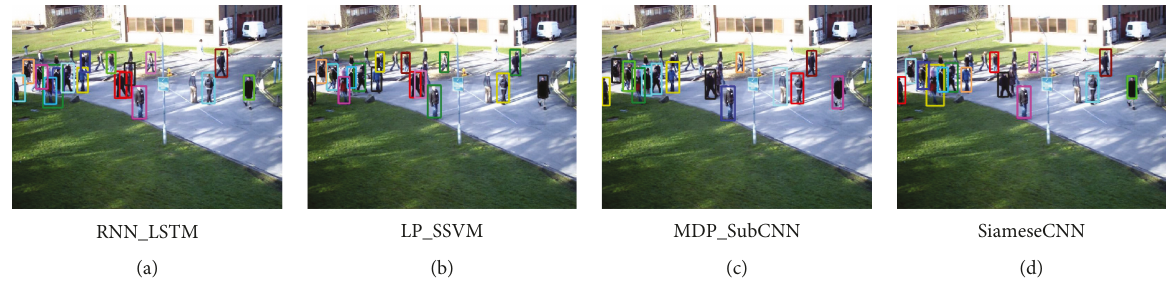
Figure 11: Sample tracking results of other trackers on frame number 15 of PETS09-S2L2.